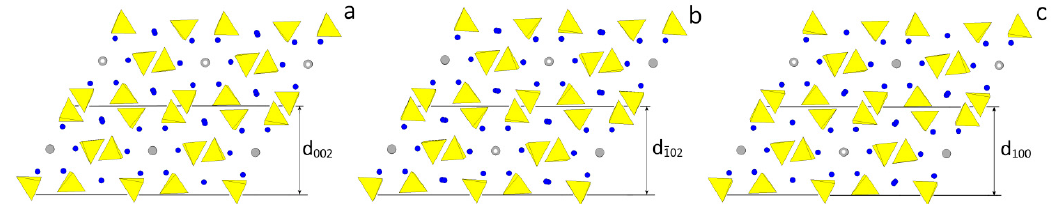
Figure 2. Projection along the structure channels of the HAp polymorph. The space group P2 1 /c has been chosen, as in Figure 1b. Hence the channels run along the [010] direction parallel to the 2 1 diad axis. Slices are defined respecting the systematic extinction rules of the P2 1 /c space group. ( a ) The structure of the slice of thickness d 002 , limiting the pinacoid {001}, shows that in two adjacent slices the OH dipoles are oriented in opposite sense. On the contrary, in ( b , c ) the structures of the slices d 102 and d 100 , limiting the pinacoids {102} and {100}, respectively, show a strong similarity (they are not identical) since, within each slice, the OH dipoles alternate up-down.